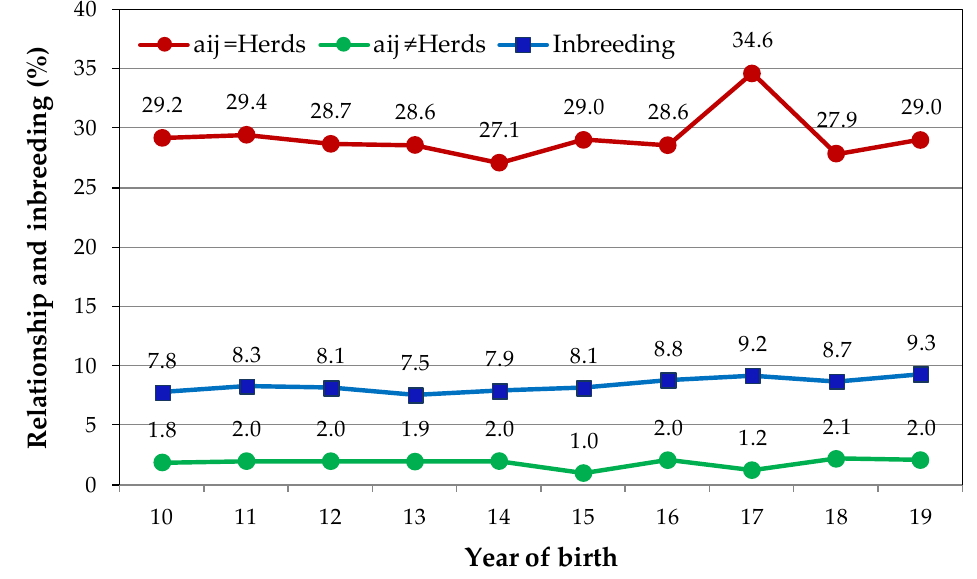
Figure 9. Average relationship ( a ij ) for animals born in same herd and born in di ff erent herds and inbreeding for calves born from 2010 to 2019.